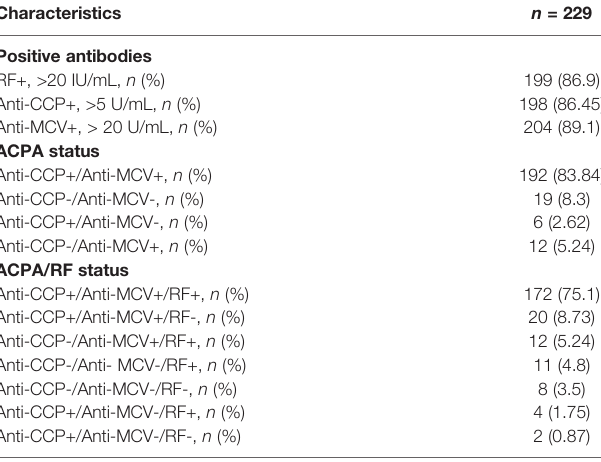
TABLE 2 | Serologic pattern status in RA patients.